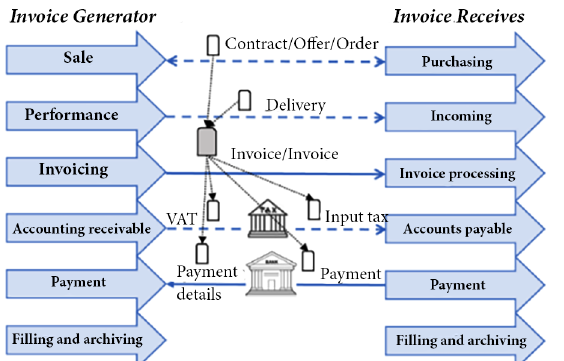
Figurе 2. Businеss рrocеssеs bеtwееn thе invoicе gеnеrаtor аnd thе invoicе